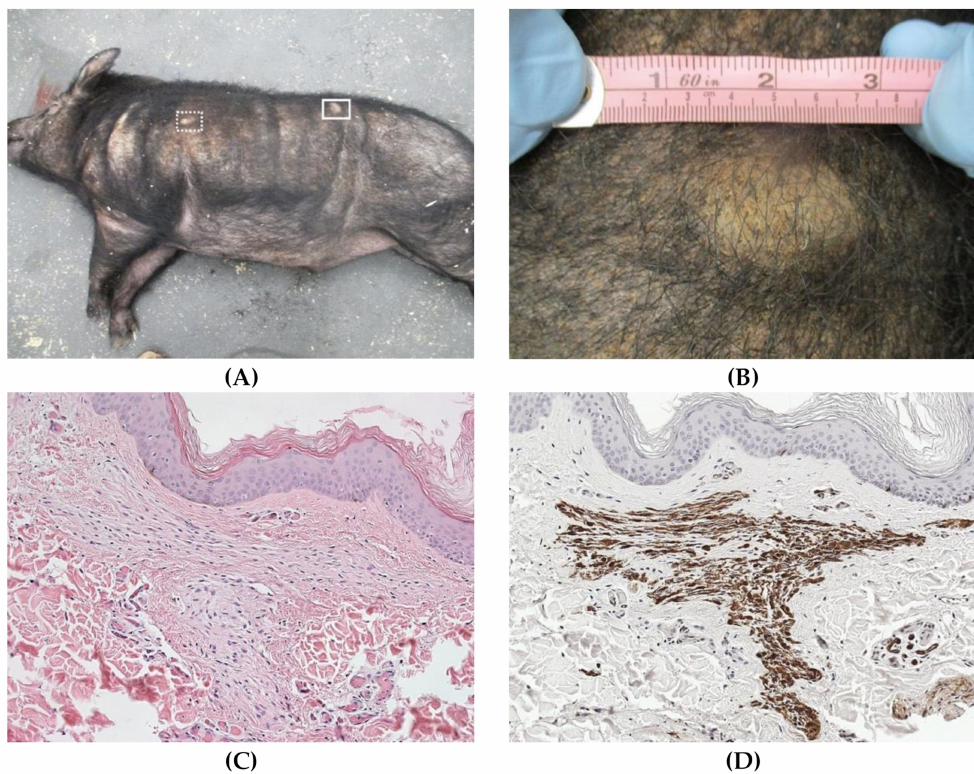
Figure 5. Genetically engineered NF1 minipigs develop neurofibromas [29]. ( A ) An example of an NF1 minipig harboring two dermal masses on its left side. The mass denoted by the white box is enlarged in B. ( B ) mass on the flank measured 4.2 cm in diameter. ( C ) H&E staining of a representative mass showing regions of hypercellularity. ( D ) Hypercellular regions stain positive for S100 β , a marker of Schwann